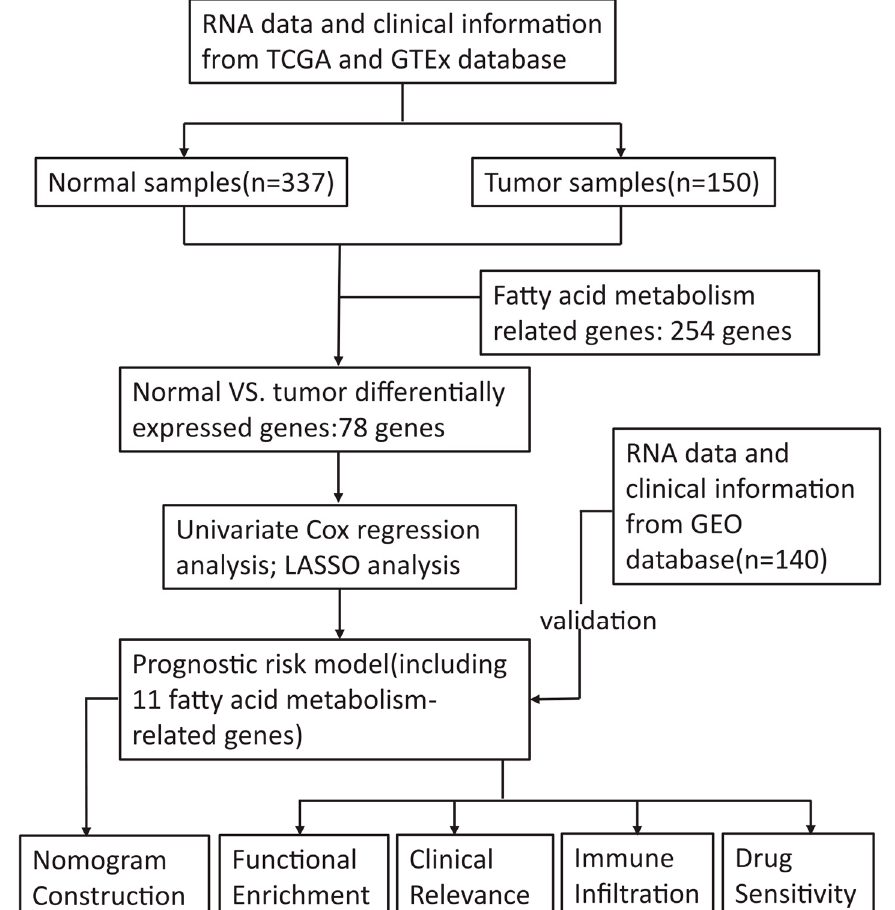
Figure 1. Flow chart of this